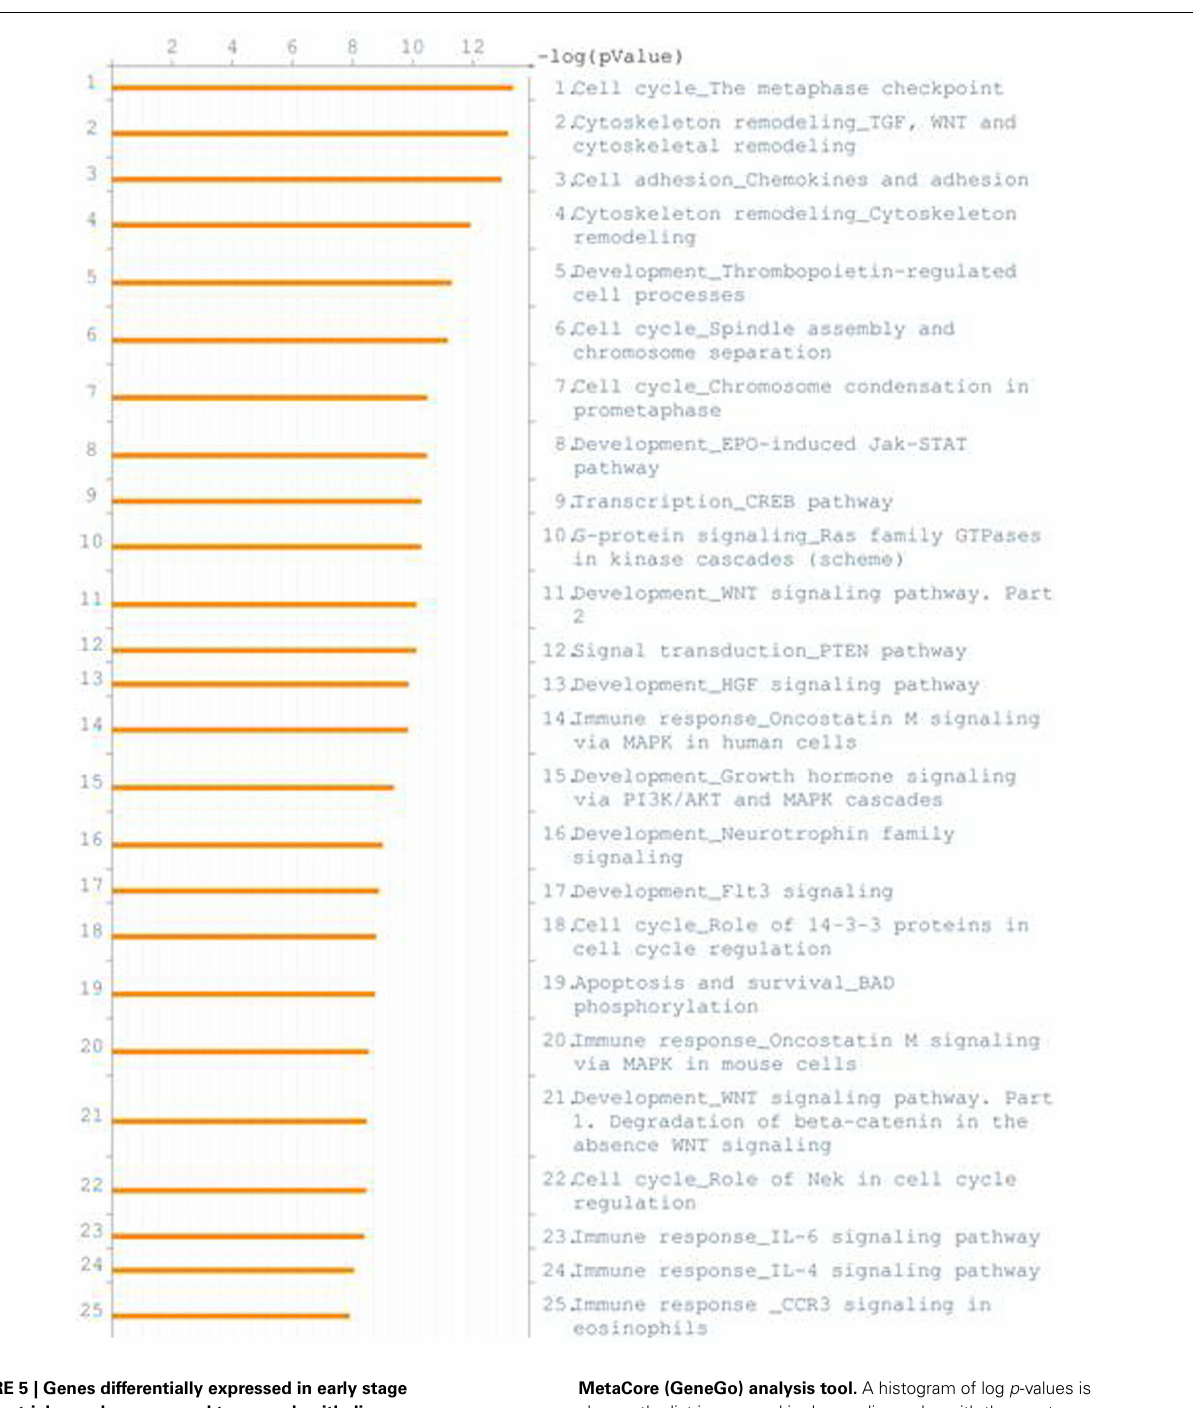
MetaCore (GeneGo) analysis tool. A histogram of log p -values is shown; the list is arranged in descending order with the most significant pathways at the